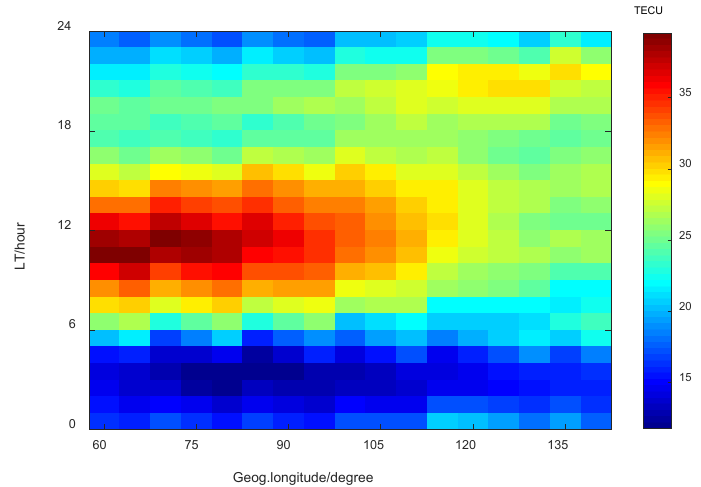
Figure 1. The solar activity index F10.7 during the years 2015–2020.